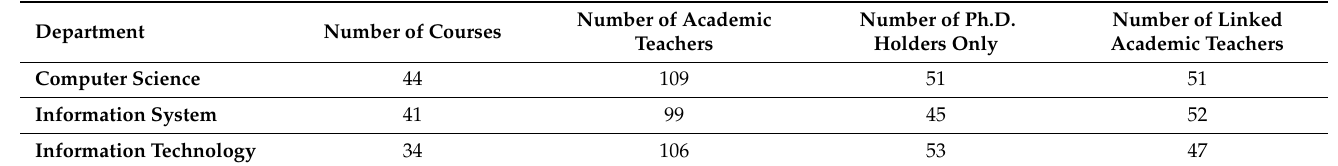
Table 2. Number of courses and academic staff in FCIT.